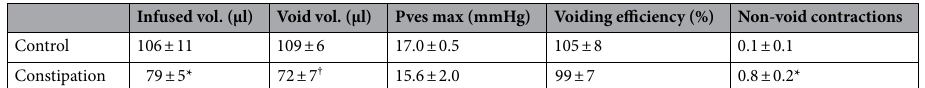
5-HT exacerbated constipation-induced detrusor overactivity.